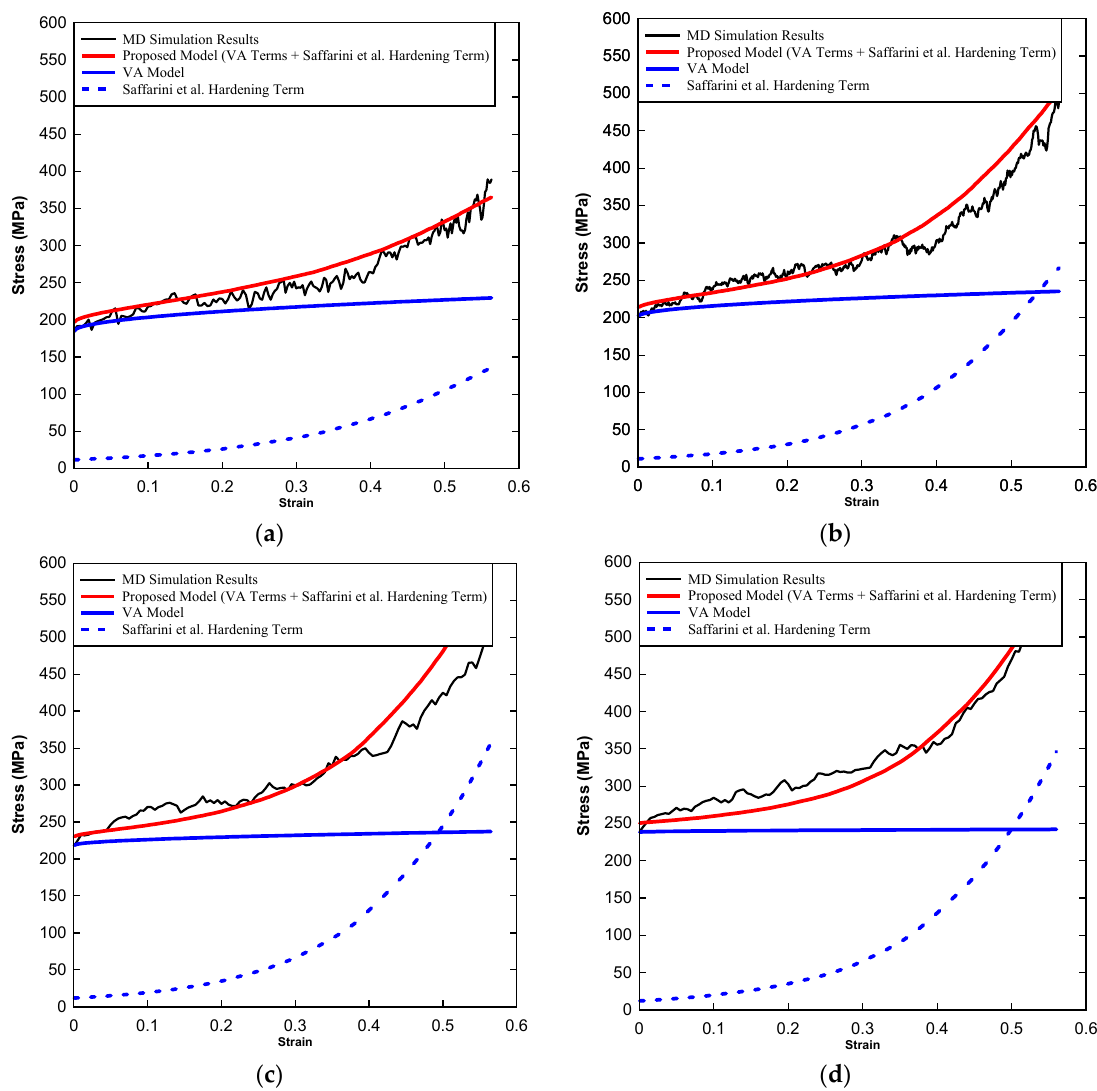
Figure 2. Model predictions of the plastic flow in gold foam compared to the MD simulation results performed in this work, the VA model predictions, and the hardening term from the Saffarini et al. model (dislocation-controlled stress component) in Equation (1) at ( a ) 𝜀(cid:4662) = 10 (cid:2875) s (cid:2879)(cid:2869) , ( b ) 𝜀(cid:4662) = 10 (cid:2876) s (cid:2879)(cid:2869) , ( c ) 𝜀(cid:4662) = 5 × 10 (cid:2876) s (cid:2879)(cid:2869) , ( d ) 𝜀(cid:4662) = 10 (cid:2877) s (cid:2879)(cid:2869) . All for the smaller sized sample with 𝐿 = 6.4 nm .